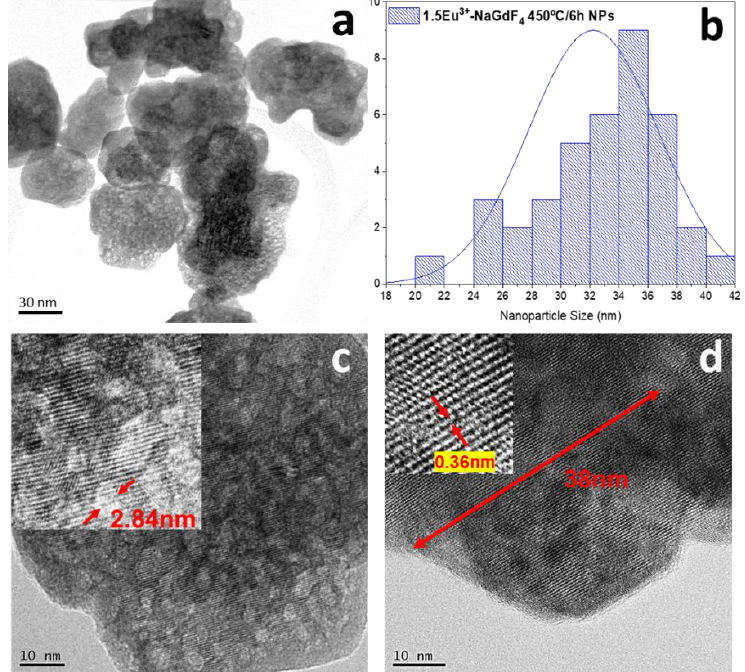
Figure 2. HR TEM images of ( a ) 1.5Eu 3+ : NaGdF 4 NPs heat-treated at 450 °C for 5 h; ( b ) the corresponding nanoparticle size distribution taken from the image on “a” ; ( c ) amplification of the area selected in “a” with the porous size measurement ; ( d ) amplification of the area selected in “a” with the lattice distance measurement.